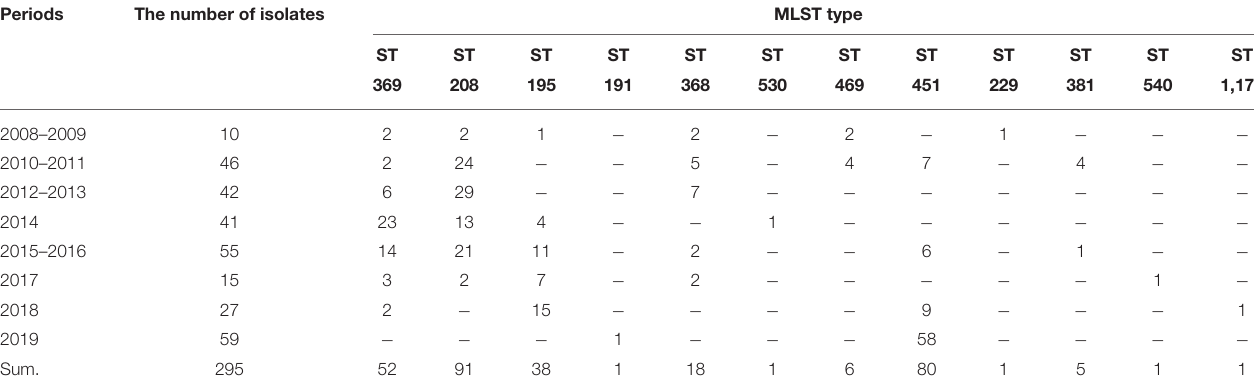
TABLE 7 | The MLST result of 295 MDR A. baumannii